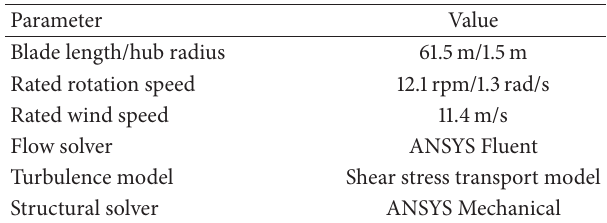
Table 1: Simulation